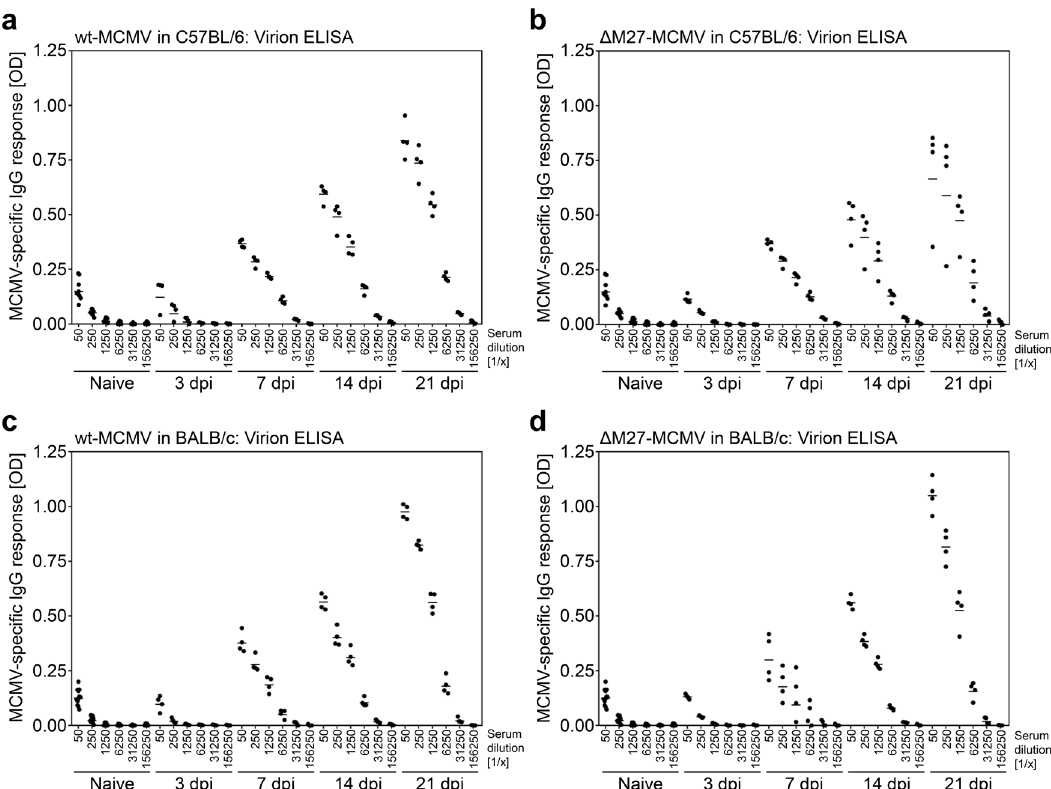
Fig. 3 Immunization with Δ M27-MCMV induces MCMV-speci fi c antibodies recognizing MCMV particles. C57BL/6 ( a , b ) and BALB/c ( c , d ) mice were infected i.p. with wt-MCMV or Δ M27-MCMV. At 3, 7, 14, and 21 dpi, serum samples were collected. MCMV-speci fi c IgG antibodies recognizing puri fi ed MCMV particles were quanti fi ed by ELISA using indicated serum dilutions. ELISA measurements were performed in triplicates. Shown is the mean of each mouse. Sera of naïve animals served as control. The geometric mean values (horizontal bars) as well as the values of individual mice ( n = 4 per group) are